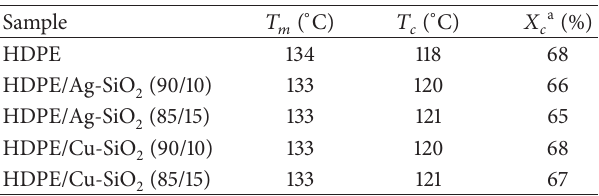
Table 3: DSC test: thermal transition properties (second run) of HDPE-based composites filled with different contents of Ag-SiO or Cu-SiO 2